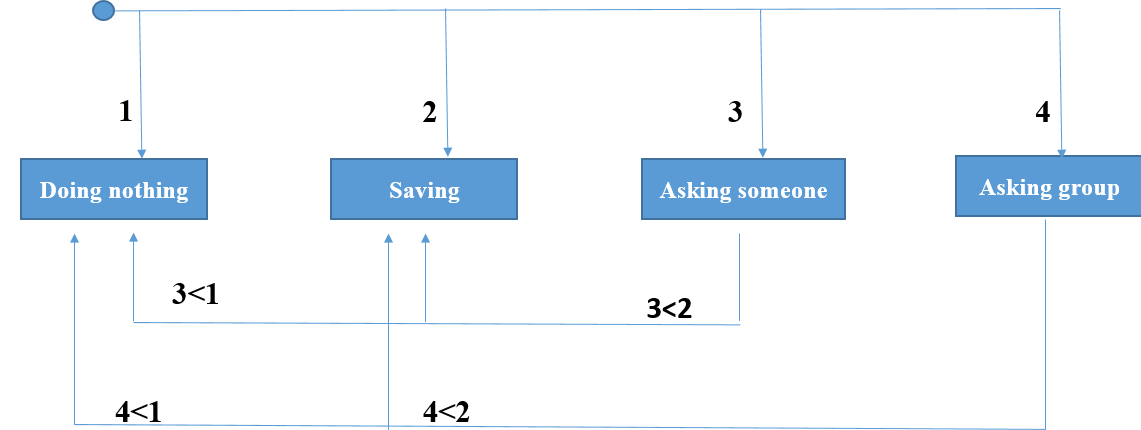
Figure A4. Situation 4—The letter. Note . 1= doing nothing; 2 = execution; 3 and 4 = communication.